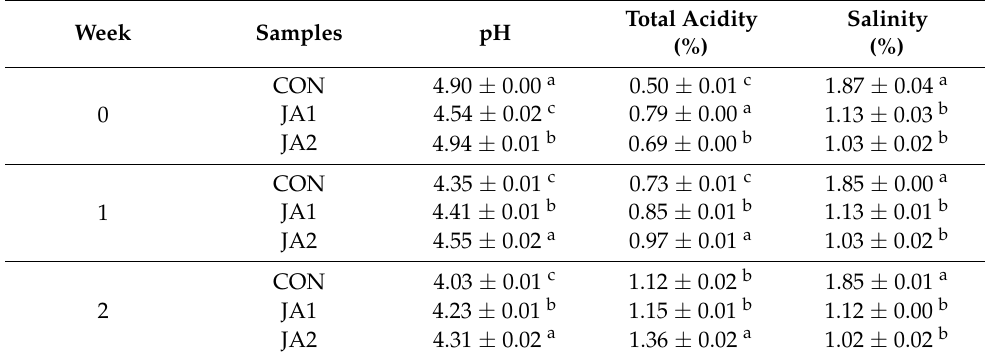
Table 6. Changes in pH, total acidity, and salinity of kimchi prepared with jeotgal alternatives.